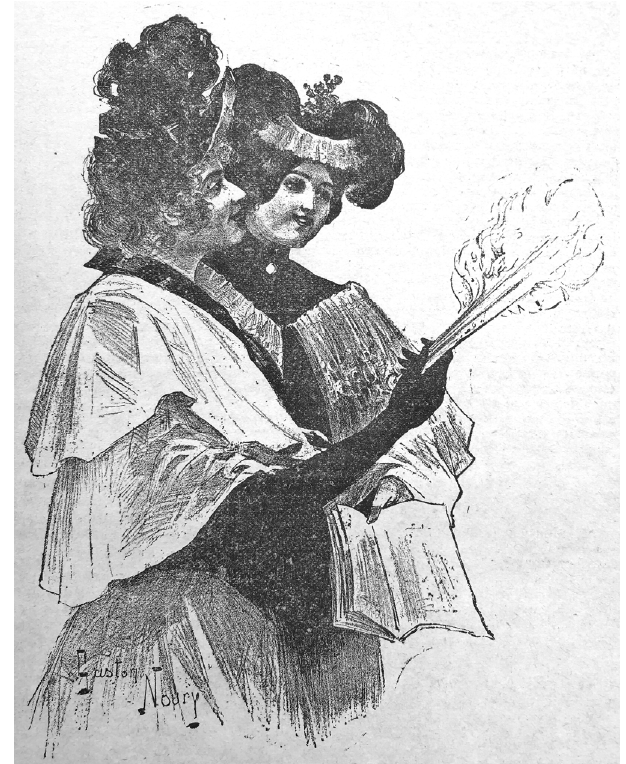
Fig. 5 Gaston Noury, ‘Réduction en noir de l’affiche Noury pour la 3me exposition du Salon des Cent’, La Plume (15 July 1894), p.